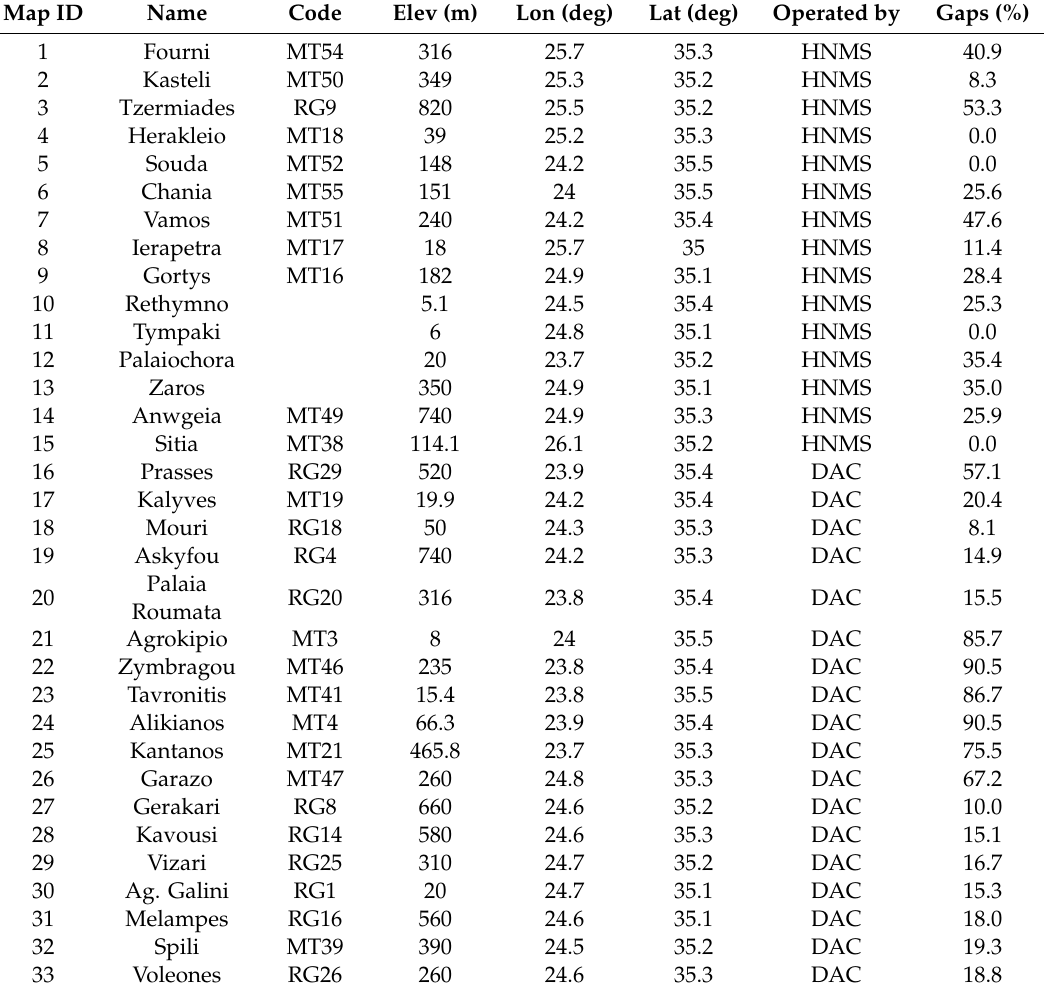
Table A1. Location and information about the precipitation stations used in this